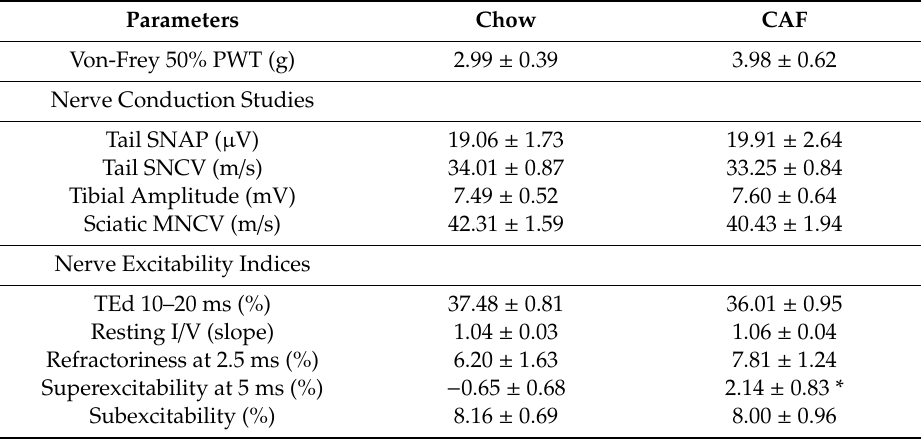
Table 2. Manual von Frey results and parameters of peripheral nerve function obtained with electrophysiological